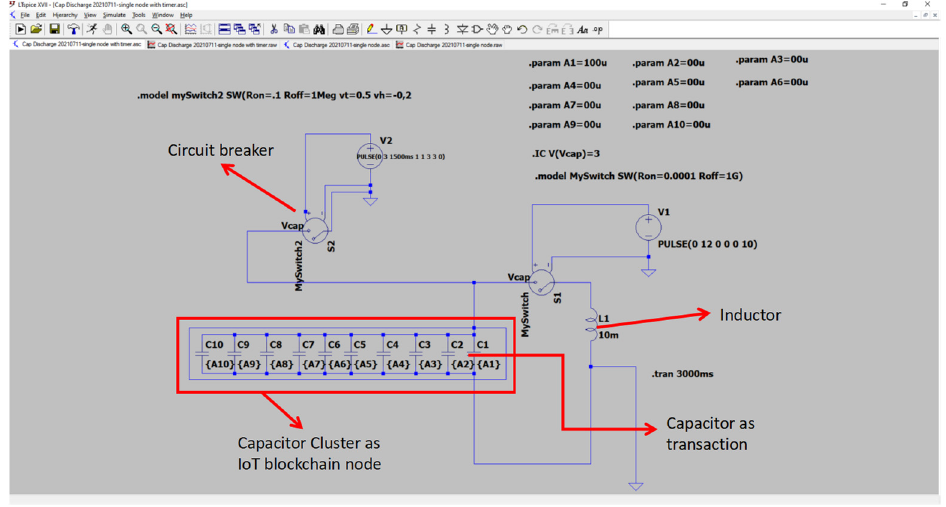
Figure 8. LTSPICE simulation setup of single node. Table 6. LTSPICE simulation parameter settings.